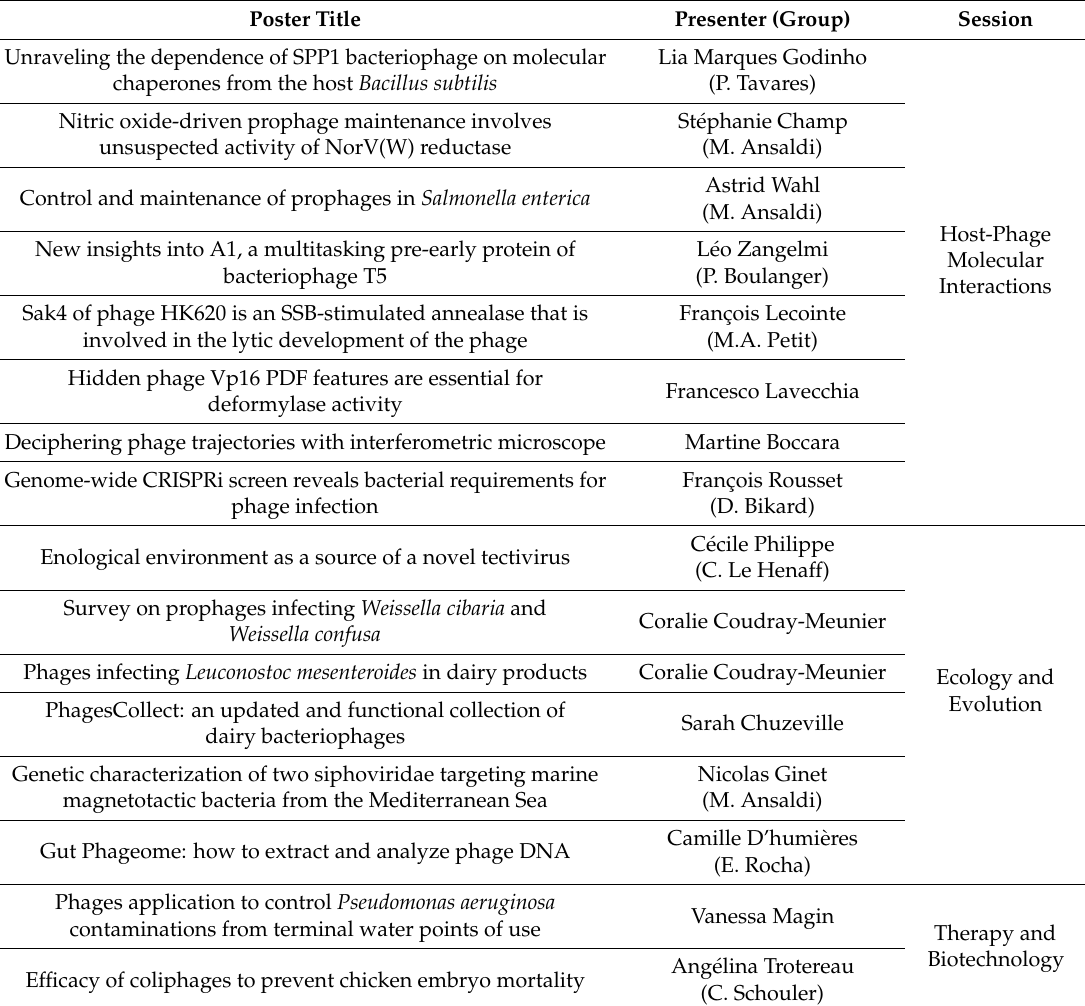
Table 1. Posters presented during the Phage-sur-Yvette 2017 meeting. Poster Title Presenter (Group) Session (P. Tavares)